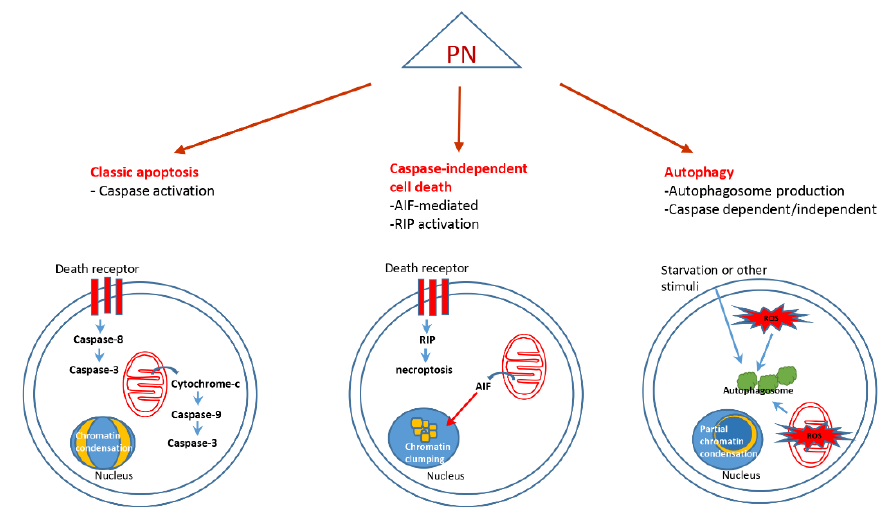
Figure 4. Different types of cell death induced by PN treatment.